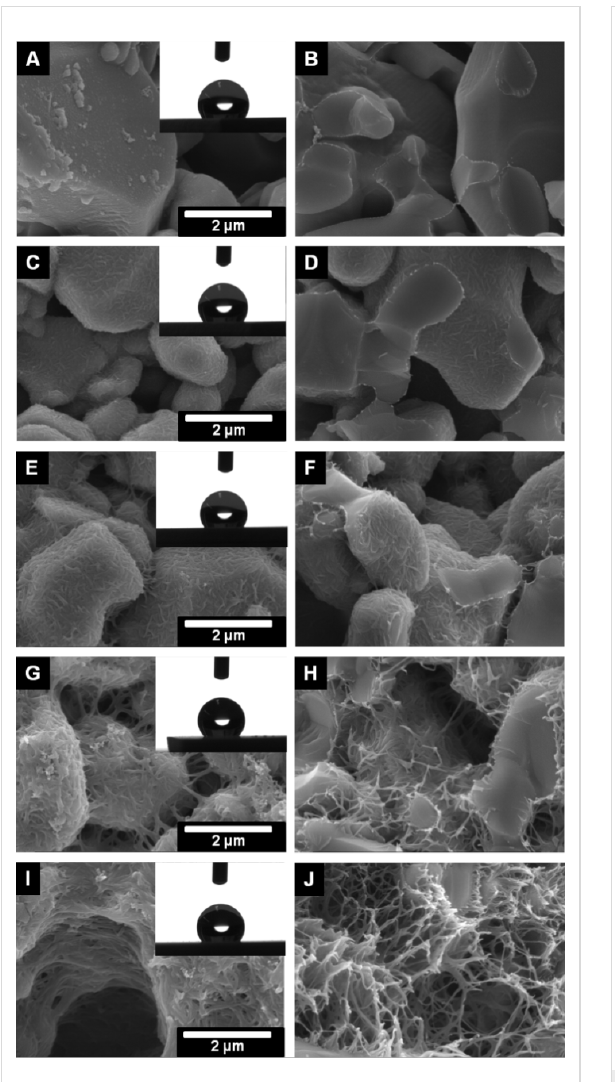
Figure 5: SEM images of the outer surface (A, C, E, G and I) and inner surface (B, D, F, H, J) of the polyphenylalanine functionalized ALOX- membranes from solvent mixture with 0 vol % (A and B), 50 vol % (C and D), 75 vol % (E and F), 90 vol % (G and H) and 100 vol % (I and J) after treatment with CHCl 3 /DCA. Inserts show the water contact angles with a volume of 2